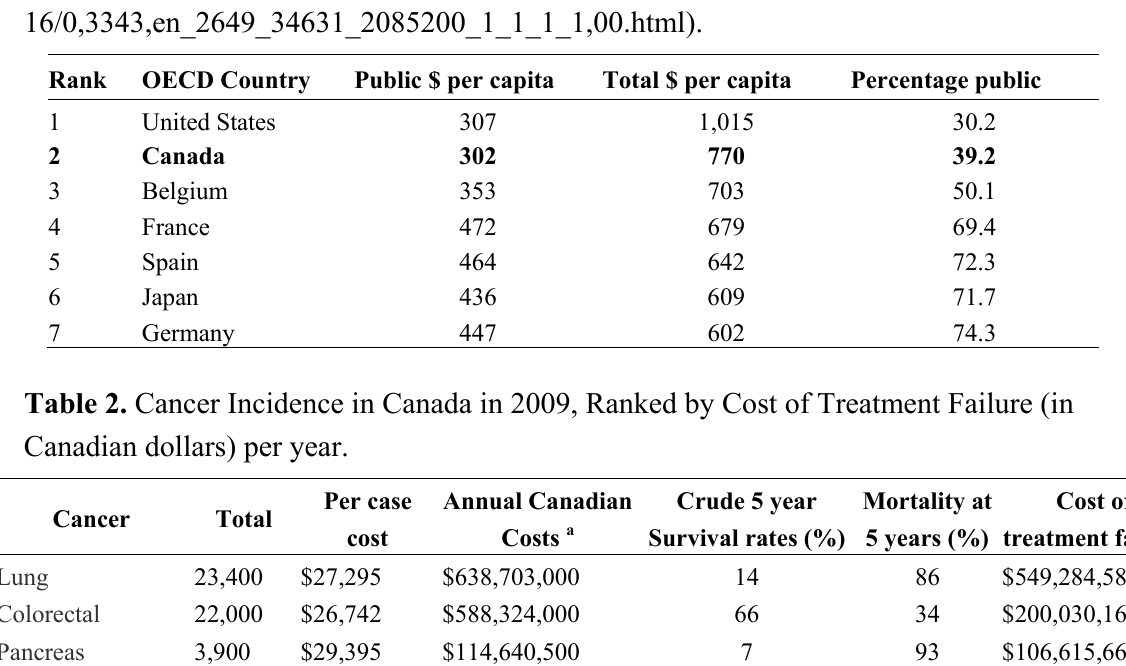
Table 1. Ranking of OECD countries by spending (in US dollars) on pharmaceuticals per capita (from OECD Health Data 2009, November 2009) (http://www.oecd.org/document/